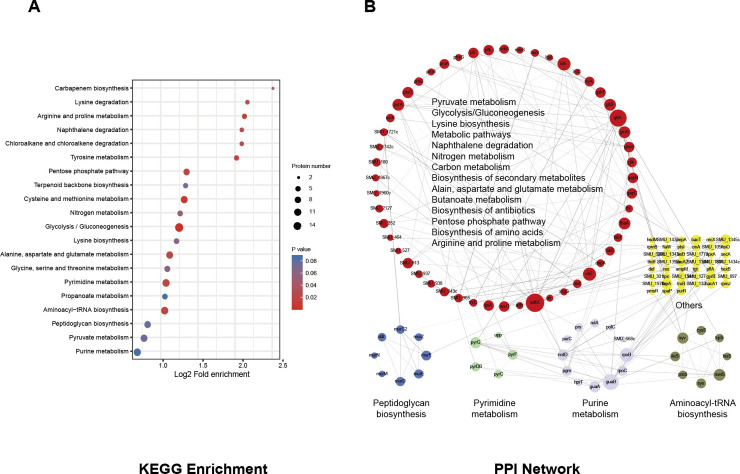
S-glutathionylation is involved in the crucial metabolic pathways of S. mutans(A) KEGG pathway-based enrichment analysis of modified proteins. A two-tailed Fisher's exact test was employed to test the enrichment of the identified modified proteins against all proteins in the species database. Pathways with corrected P < 0.05 were considered significant. (B) STRING-based analysis of PPI networks of identified modified proteins. Different colors display various clusters according to KEGG pathway enrichment. The size of the node represents the value of the degree, and the width of the edge represents the EdgeBetweenness.